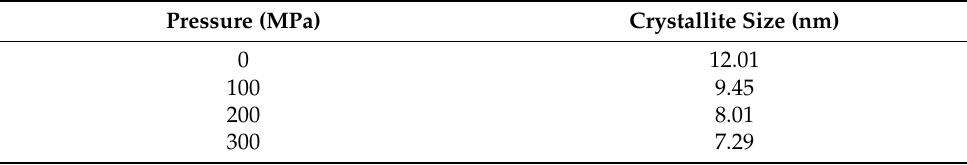
Figure 11. XRD curves during the isothermal-solidification process with different pressures. Table 2. Crystallite size after the isothermal-solidification process with different